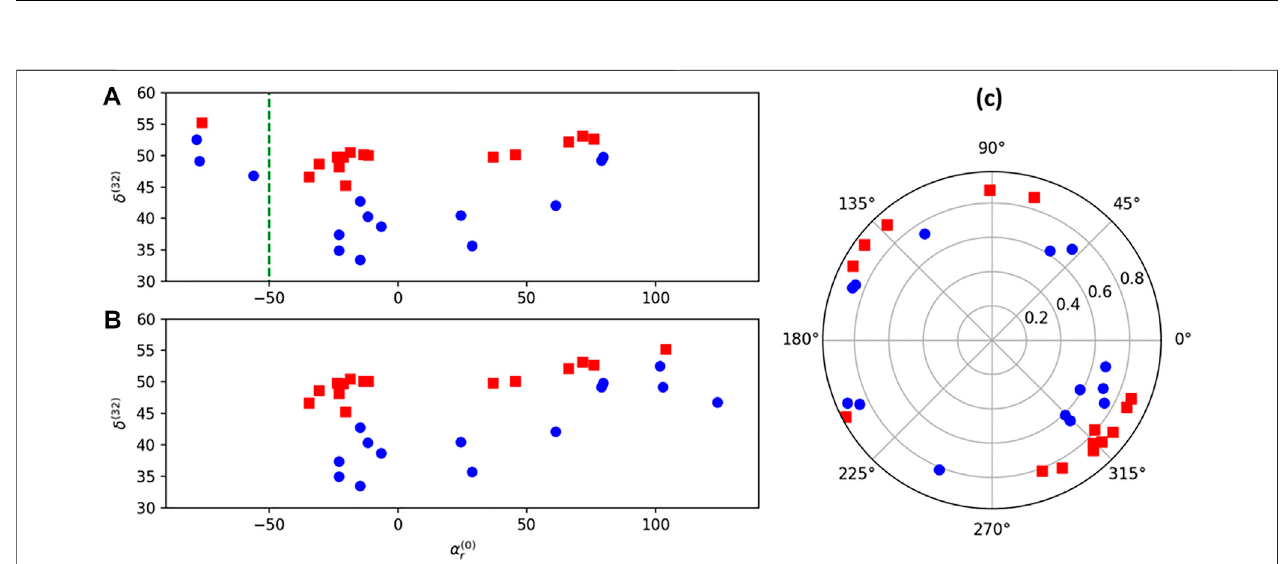
FIGURE 5 | Scatter plot of α ( 0 ) r and δ ( 32 ) , drawn in Euclidean (A) and polar (B) coordinates. For (B) , the angle of the scatter plot is 2 α ( 0 ) r and the radius is δ ( 32 ) .